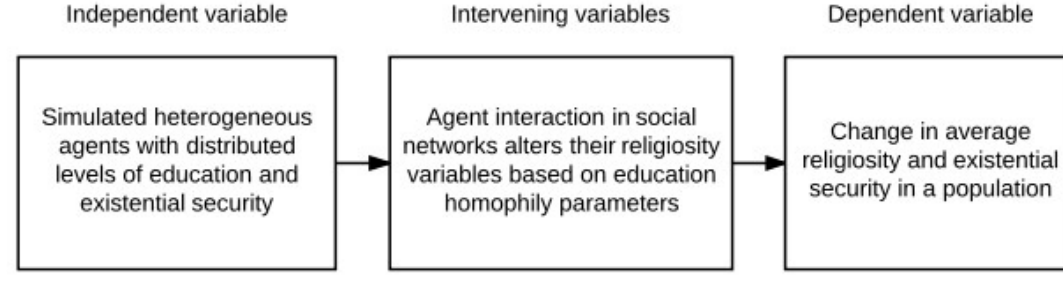
Figure 5: Variable dependencies within